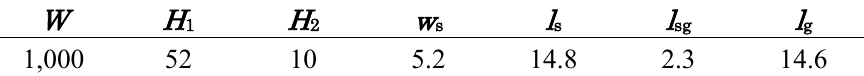
Table 2. Dimensions of the sensor ( μ m) used in the experiment.